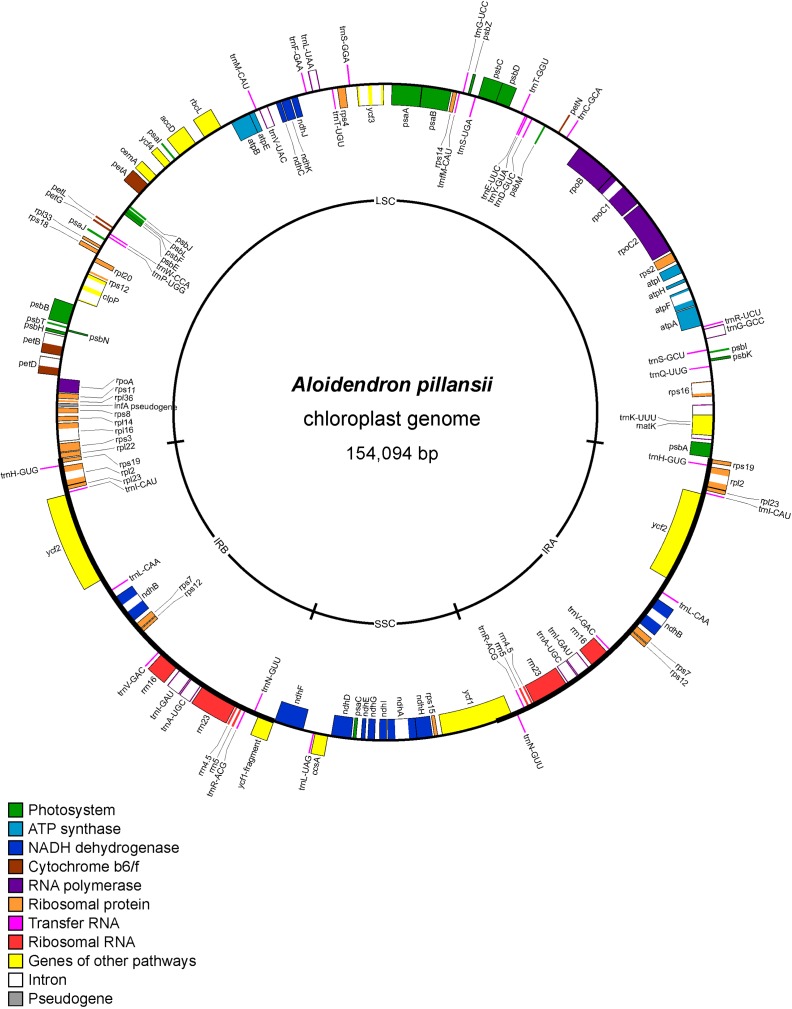
Gene map of Aloidendron pillansii chloroplast genome (GenBank MN276325). Genes illustrated inside the circle are transcribed in a clockwise direction relative to the figure, and genes outside the circle are transcribed in an anticlockwise direction.